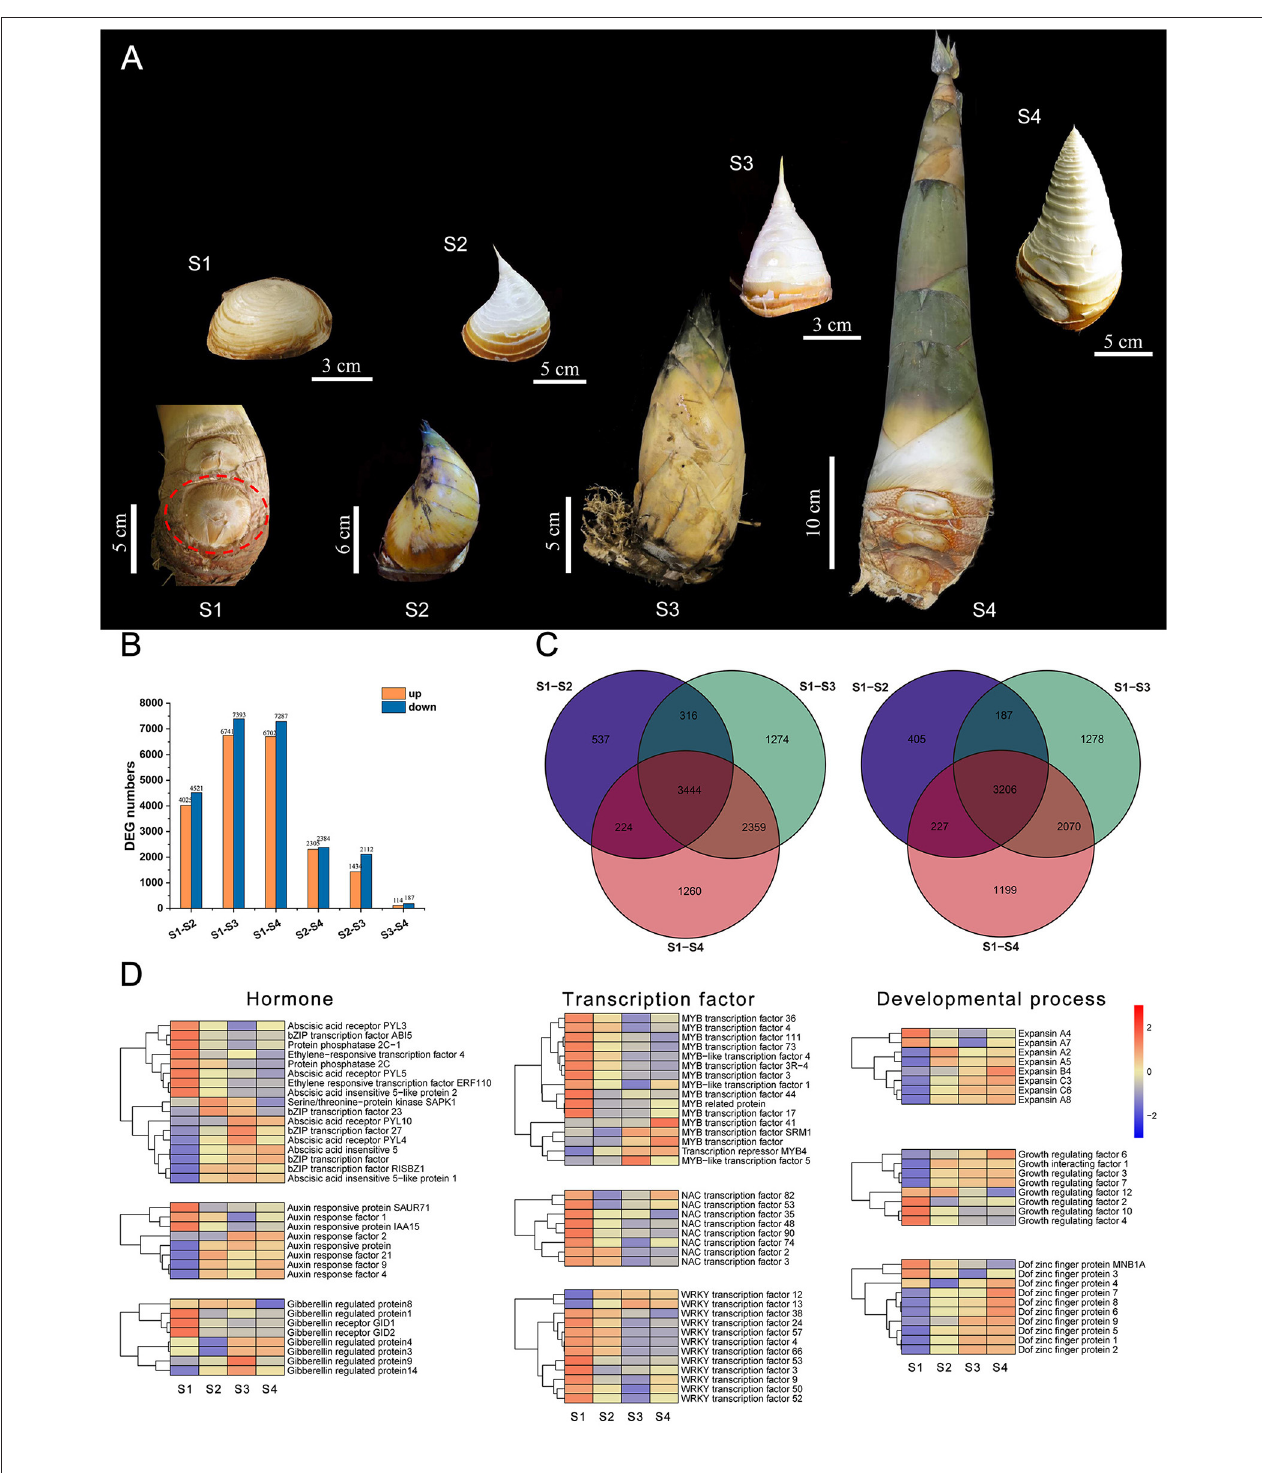
FIGURE 7 | Transcriptome analysis of shoot buds at different developmental stages in Ma bamboo. (A) A total of four representative developmental stages of Ma bamboo apical bud were characterized by the length of bamboo shoot. The red dotted line represents the position of shoot buds in S1. A separate scale of each image is shown separately. (B) The number of differentially expressed genes between different stages was counted by transcriptome analysis. Yellow and blue represent upregulated and downregulated differentially expressed genes, respectively. (C) Venn diagrams of differentially expressed genes in three group. Left and right represent upregulated and downregulated, respectively. (D) The expression levels of three kinds of differentially expressed genes in transcriptome data were related to hormones, transcription factors, and developmental process, respectively. Yellow and blue represent upregulated and downregulated differential expression,